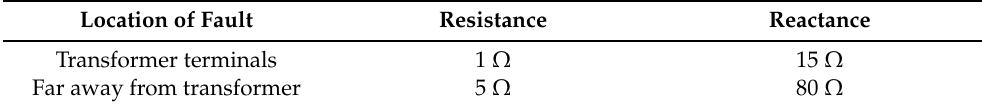
Table 4. Range of impedances used in the calculation of the phase